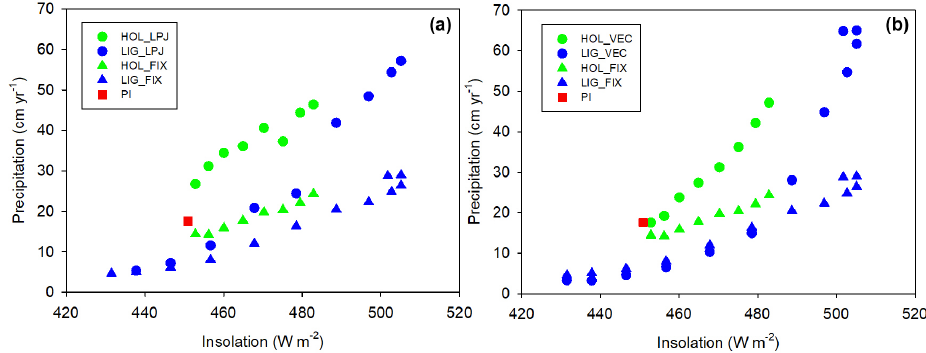
Figure 6. The relationship between insolation at 20 ◦ N and precipitation with dynamic vegetation from LPJ-GUESS (a) and VECODE (b) during two interglacials, with blue dots representing the LIG and green dots representing the Holocene. For reference, the results of HOL_FIX, LIG_FIX, and PI are also